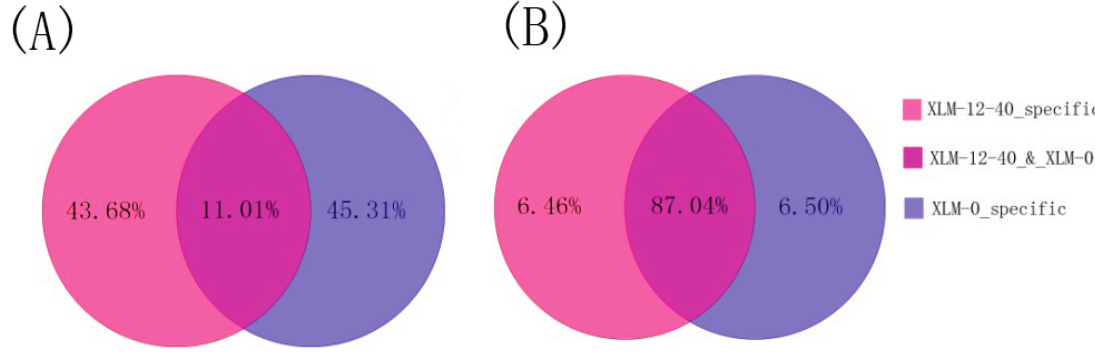
Figure 1. The distribution of sRNA in two libraries ( A ) sRNA counts; ( B ) unique sRNA.